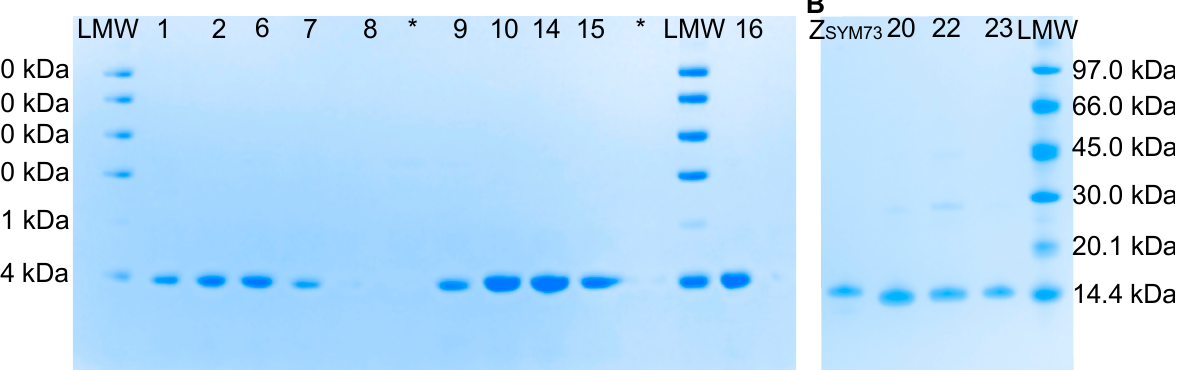
Figure 3. Sodium Dodecyl Sulphate–Polyacrylamide Gel (SDS-PAGE) analysis of produced sequestrins Sq A β with 1.5 μ g loaded per construct, at expected weight of 13 kDa. ( A ) Sequestrins from third and fourth cycle. LMW: low molecular weight ladder. ( B ) Sequestrins from fifth cycle. * Lanes intentionally left empty.